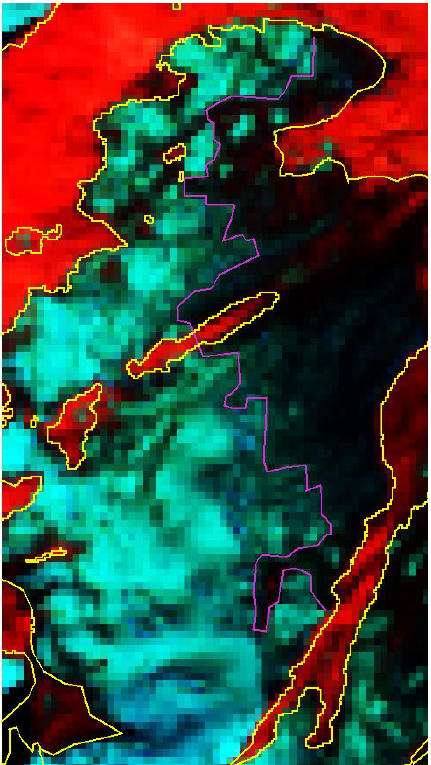
Figure 14. Example of glaciers discarded from our study due to a too chaotic zone where the SLA can be found. The ground truth snow line is in